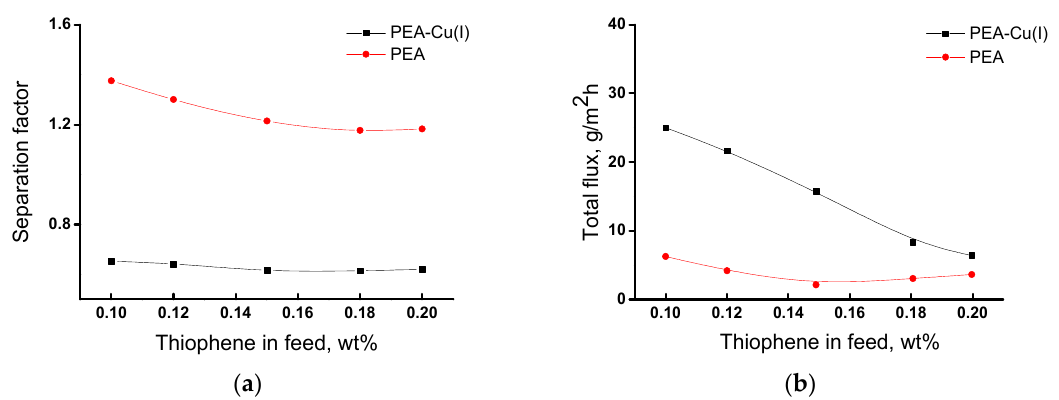
Figure 8. Dependence of ( a ) separation factor α thiophene/ n -heptane and ( b ) total flux of the membranes on the thiophene concentration in the feed, 20 ° С .